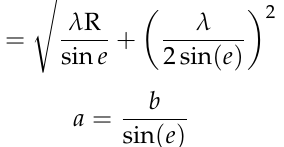
axis instead ranges from roughly two to one